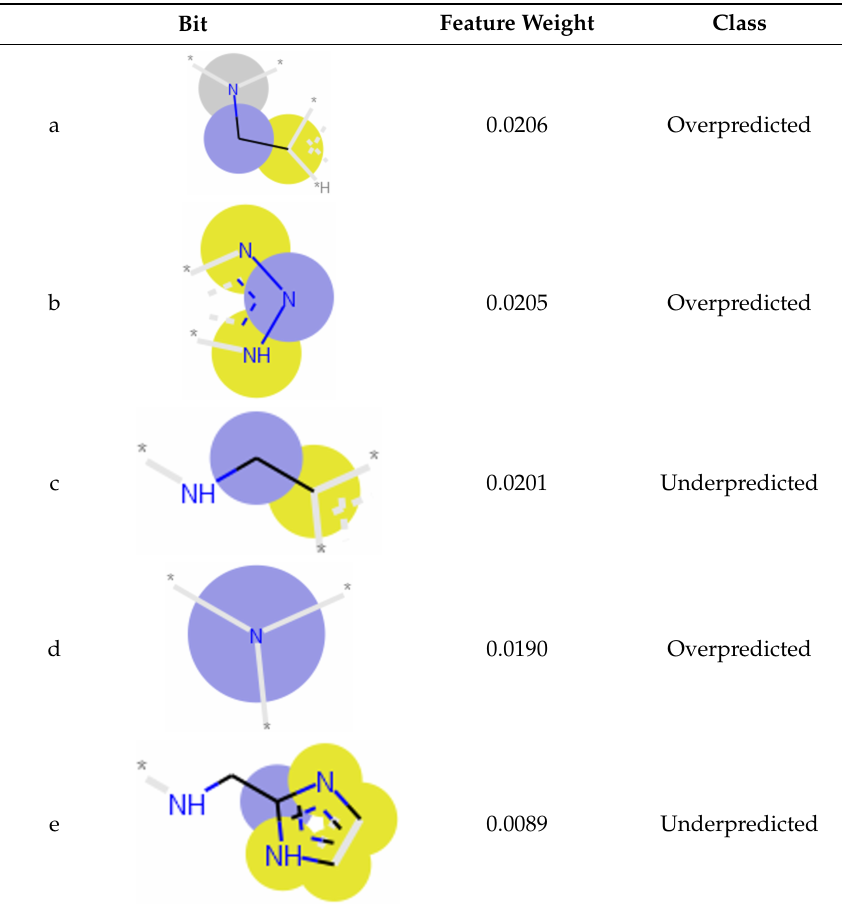
Table 3. Examples of important bit vectors of a molecular fingerprint(s) which were identified as features indicative of compounds with a ffi nities that were over- or underpredicted by the Vina scoring